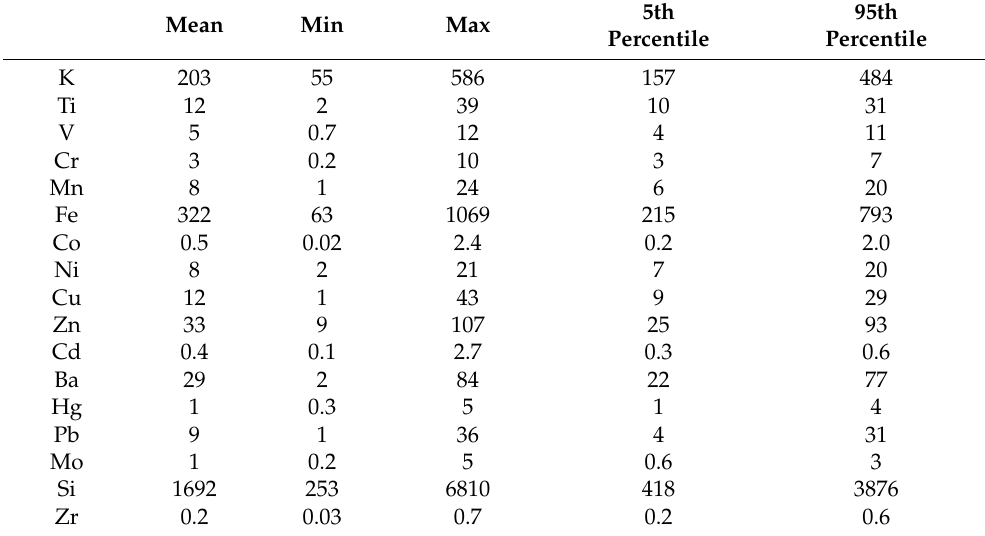
Table 2. Concentrations of mean, minimum, maximum, 5th percentile, 95th percentile of the ana- lytes determined, expressed in ng m − 3 , for Biella site.